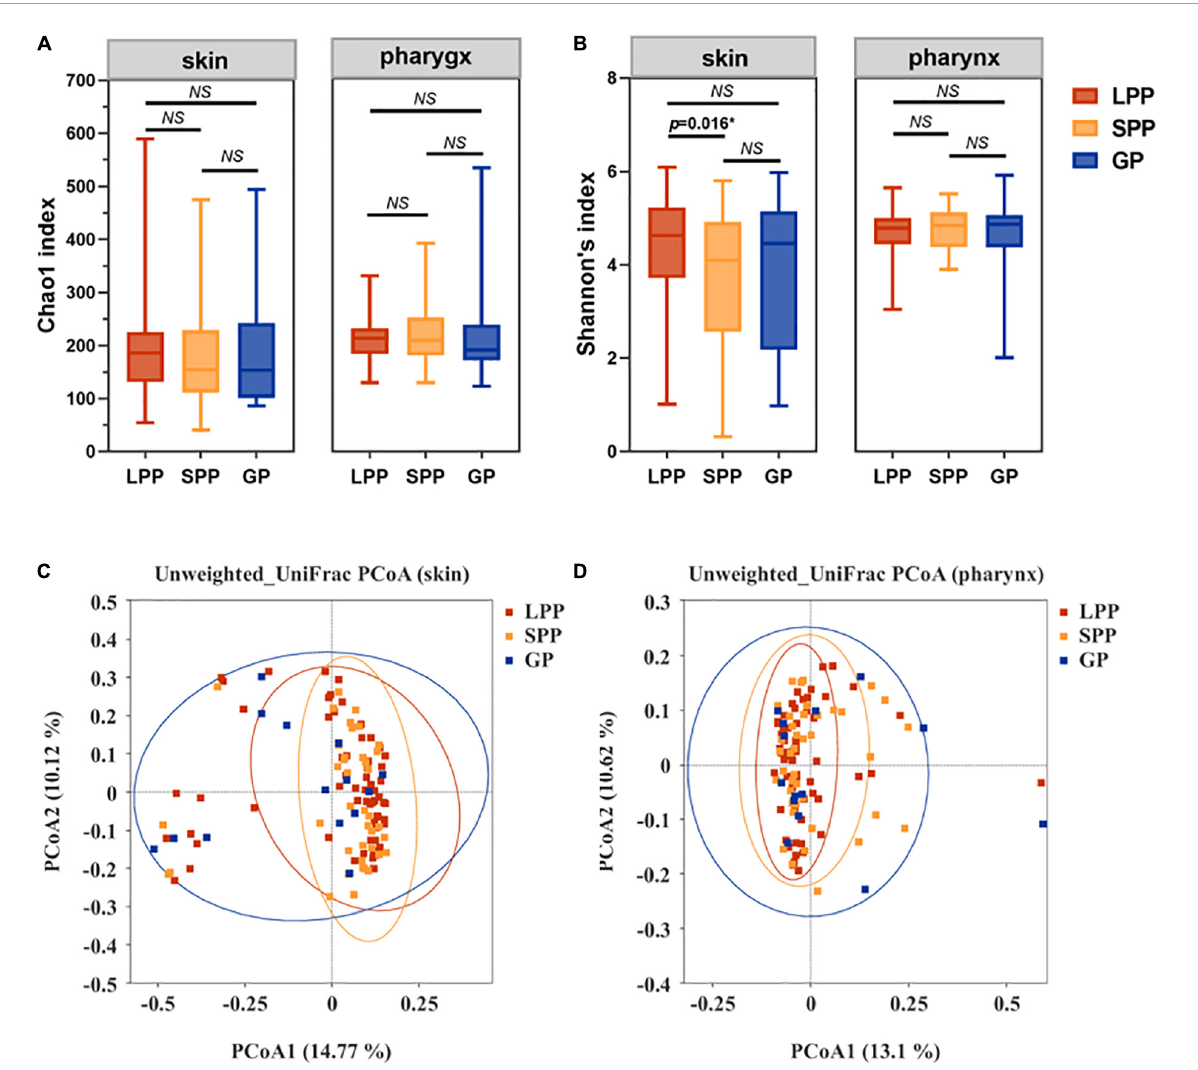
FIGURE1 Comparison of the construction and diversity of the skin microbiota among the GP, SPP, and LPP subjects. (A,B) Alpha-diversity indices analysis based on indices of Chao1 (A) and Shannon (B) within each group of skin microbiota, respectively. Horizontal bars within boxes represent the median. The tops and bottoms of boxes represent the 75th and 25th quartiles separately. (C,D) Unweighted UniFrac PCoA (C) and Weighted UniFrac PCoA (D) plots of skin microbiota from the GP (green), SPP (blue), and LPP (red) groups. The points in different colors represented the skin microbial structure of the samples in each group. * p < 0.05. NS, no significance; PCoA, principal coordinate